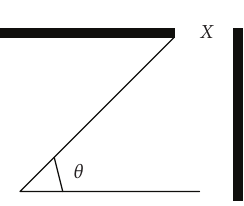
Figure 6: Tapering angle and distance